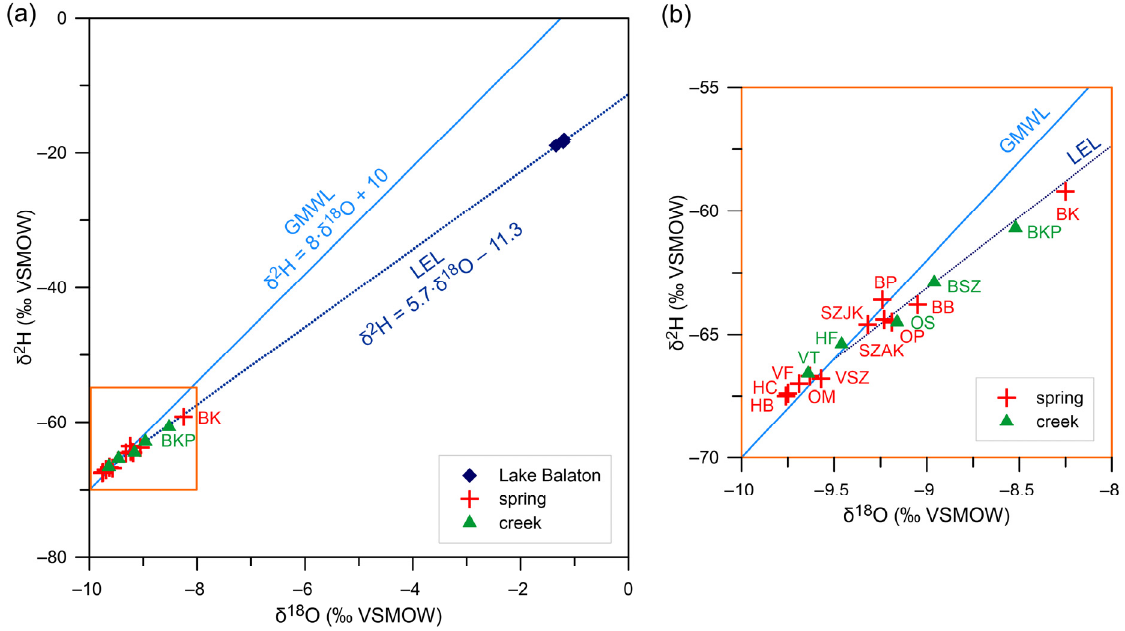
Figure 8. Oxygen and hydrogen stable isotopes plotted with the global meteoric water line (GMWL, Craig [110]) and the fitted local evaporation line (LEL). ( a ) All water samples, ( b ) zooming in on a selected part of the plot .